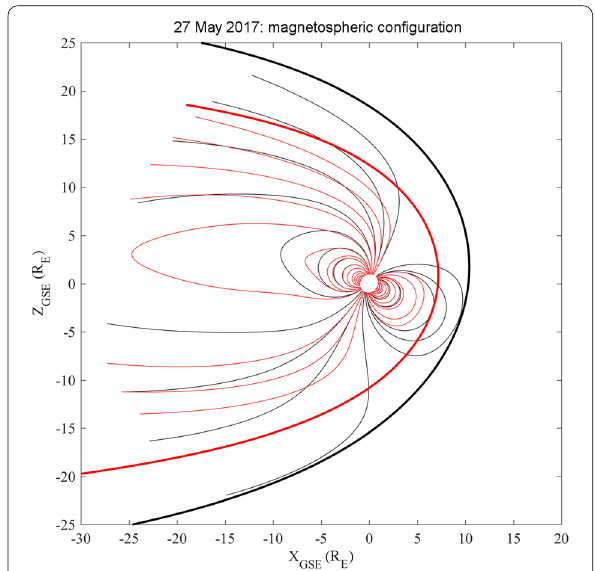
Fig. 4 Magnetospheric field lines configuration as evaluated by the TS05 model before (black lines) and after (red lines) the IS impact. Black and red thick curves represent the magnetopause configuration before and after the IS passage, respectively